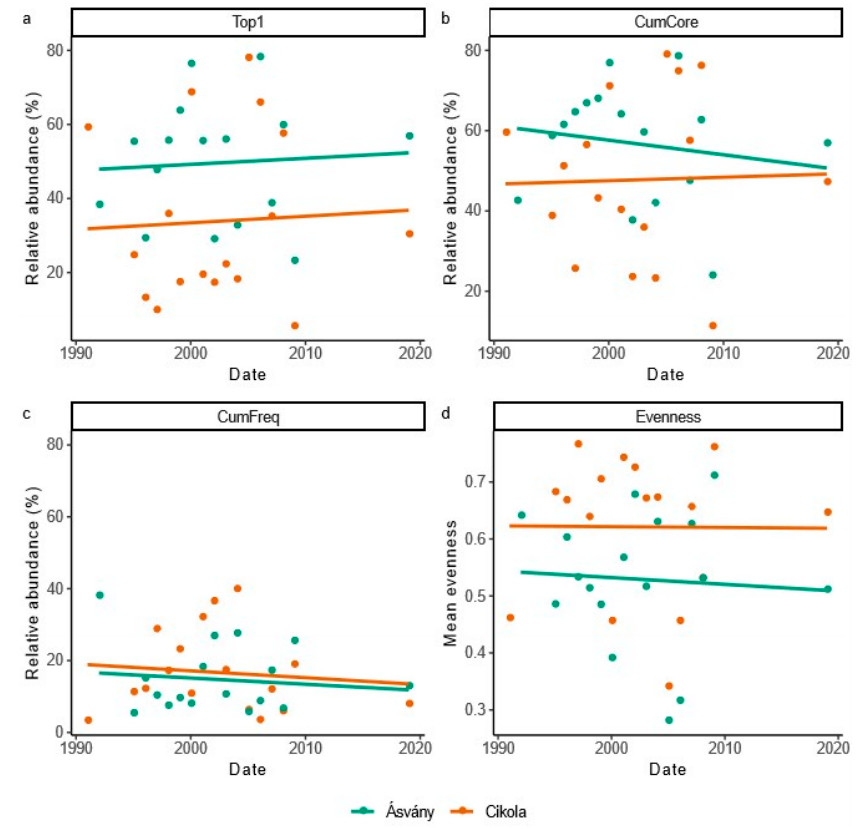
Figure 5. Annual cumulative relative abundance in Top1 ( a ), core ( b ), and common ( c ) diatom species and evenness ( d ) in the Á sv á ny (green) and Cikola (orange) tributary systems with fitted linear and evenness ( d ) in the Ásvány (green) and Cikola (orange) tributary systems with fitted linear trend trend line.